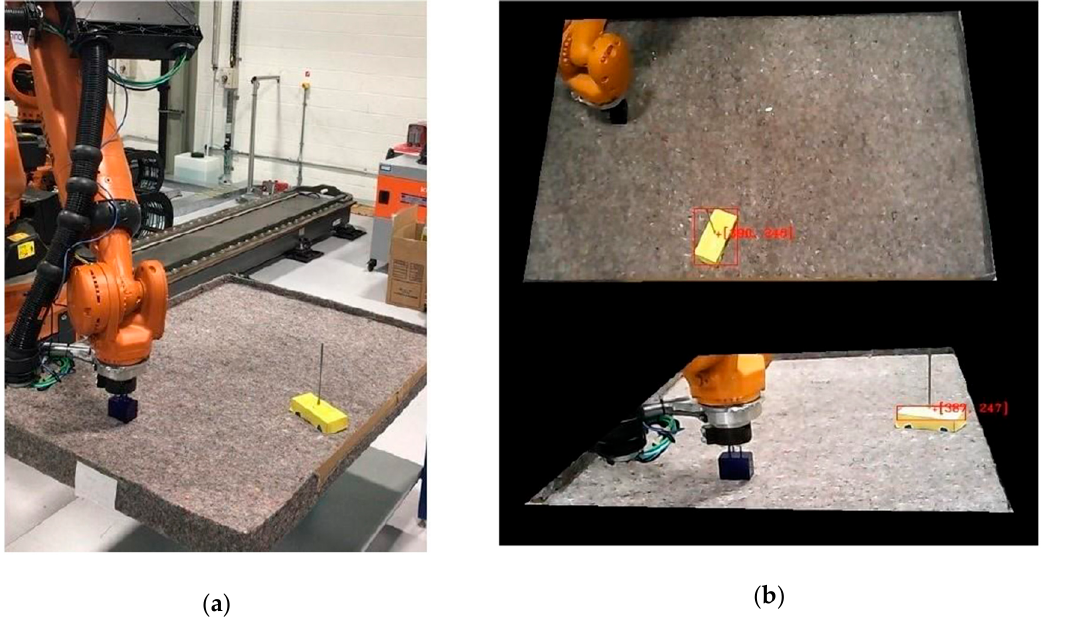
Figure 17. Synchronized video frames captured during operation [22]: ( a ) A real video frame taken from the safety area showing all object configurations in the environment; ( b ) Acquired frames by Cam-1 (top) and Cam-2 (bottom) from machine vision.